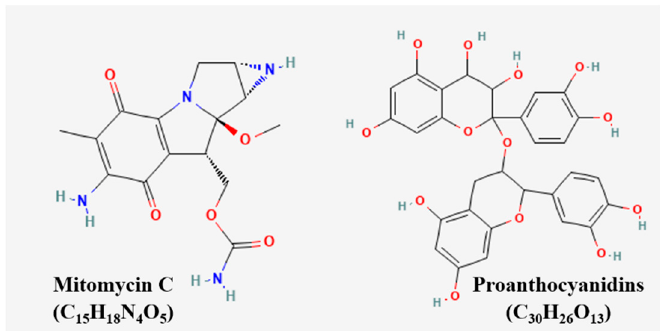
Figure 9. Chemical structures of compounds used in the clinical trials.